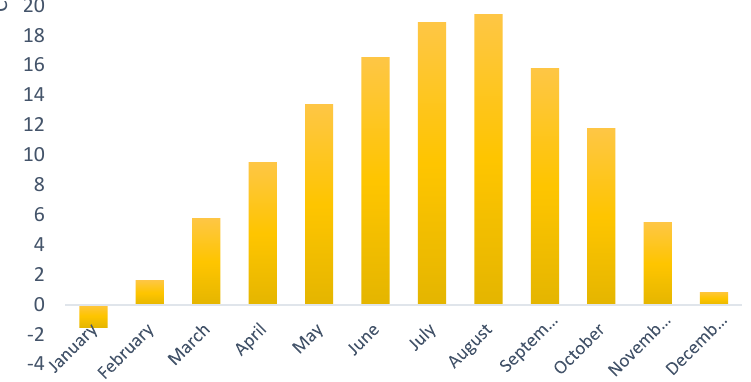
Figure 3. The average monthly dry bulb temperature of Sarein in a typical year.